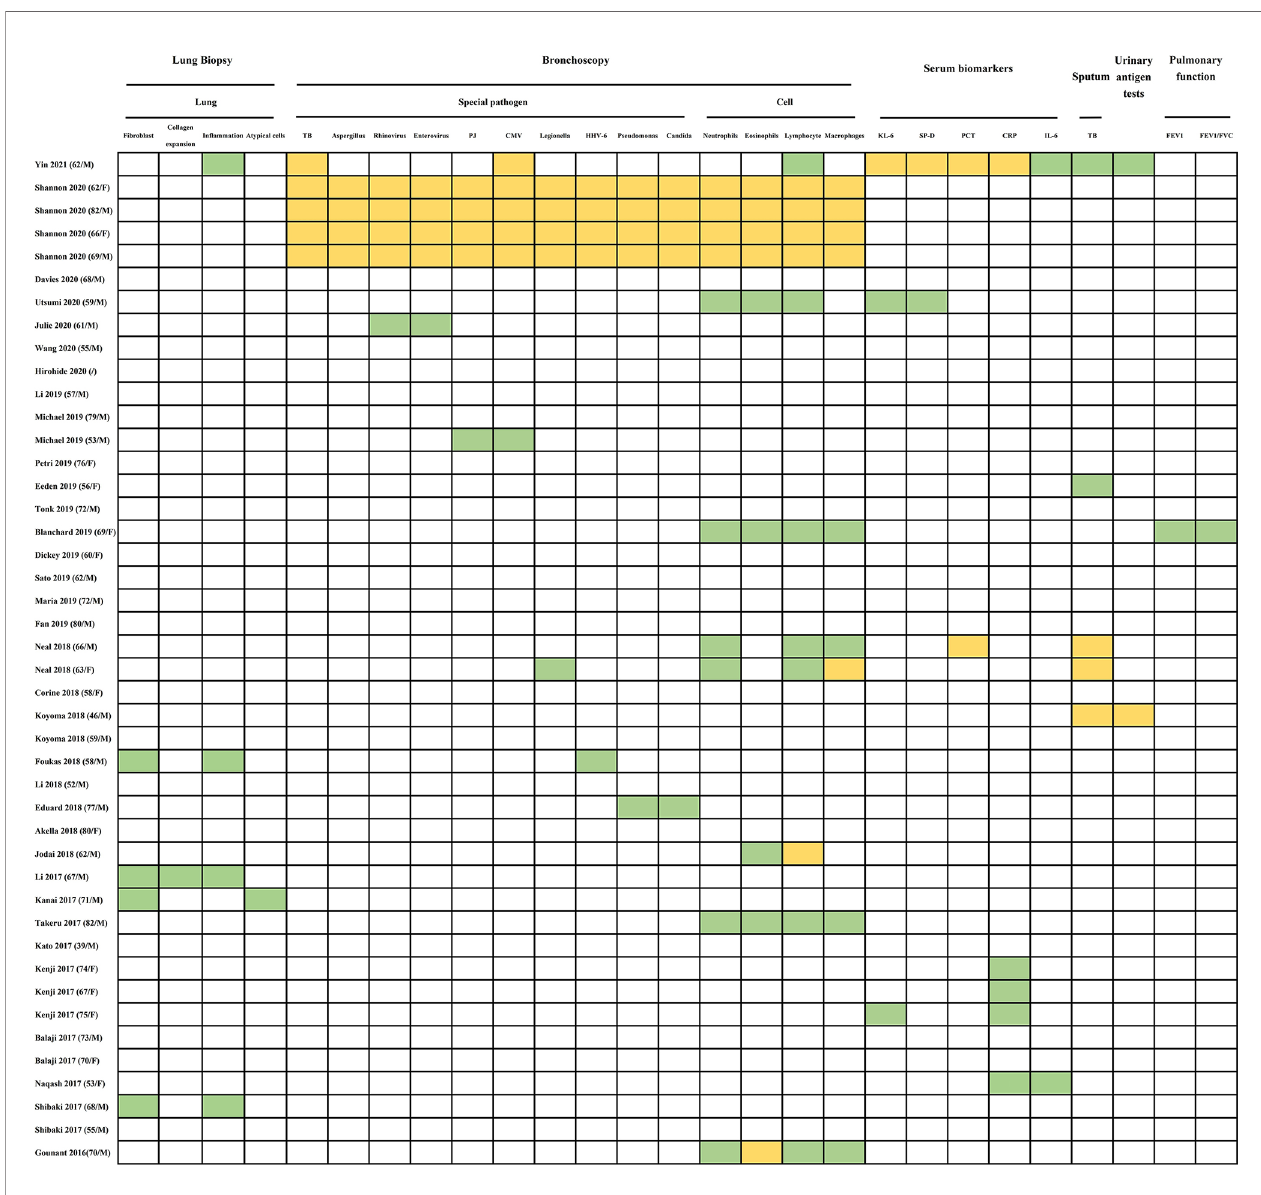
FIGURE 3 | Summarized results of histological, laboratory and pulmonary function tests for diagnosis in published cases reports/case series. The histological test includes lung biopsy. The laboratory tests include BAL (special pathogen and cells) in bronchoscopy, serum, sputum, urinary antigen test. The pulmonary function tests include FEV1 and FEV1/FVC. TB, tuberculosis; PJ, pneumocystis jirovecii; CMV, cytomegalo-virus; HHV-6, human herpes virus 6; KL-6, krebs von den Lungen- 6; SP-D, surfactant protein-D; PCT, procalcitonin; CRP, C-reactive protein; IL-6, interleukin-6; FEV1, forced expiratory volume in one second; FEV1/FVC, fractional volume change. Abnormal: green grid; normal: orange grid; undone: white